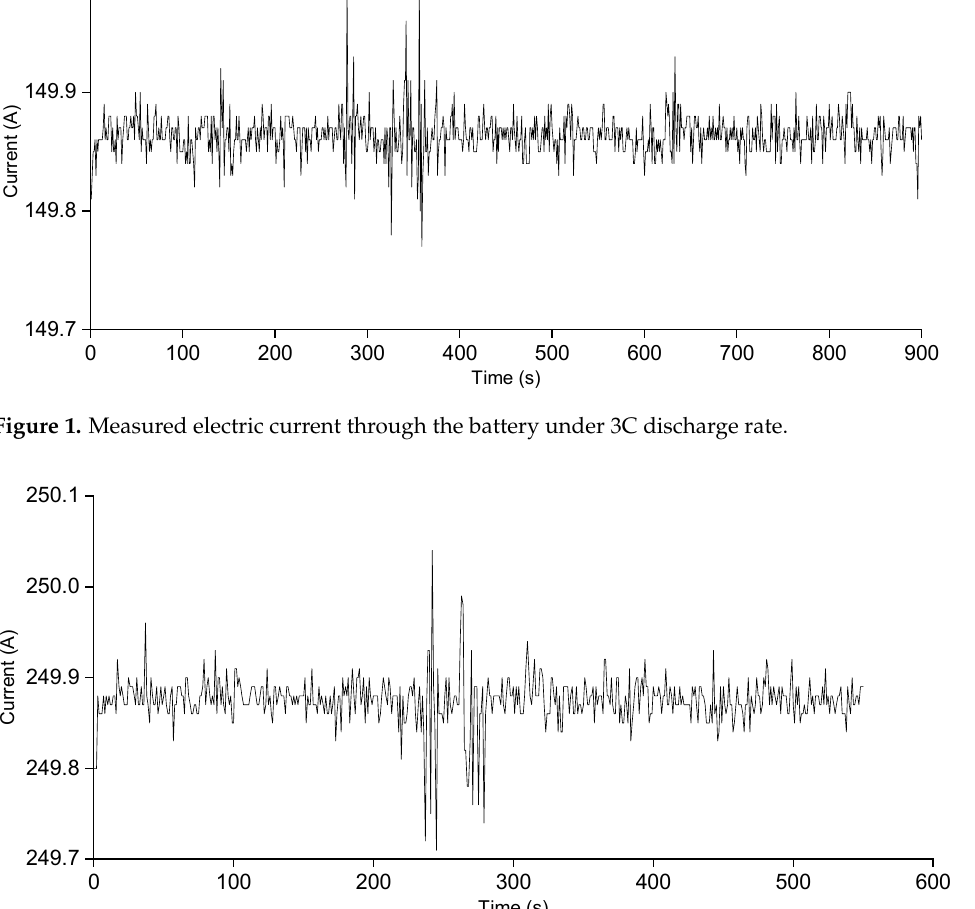
The open-circuit voltage is determined from the terminal voltage by Equation (6). The entropic heat coefficient, which is estimated in Equation (7), is the derivative of the open-circuit voltage with respect to battery temperature, as shown in Figure